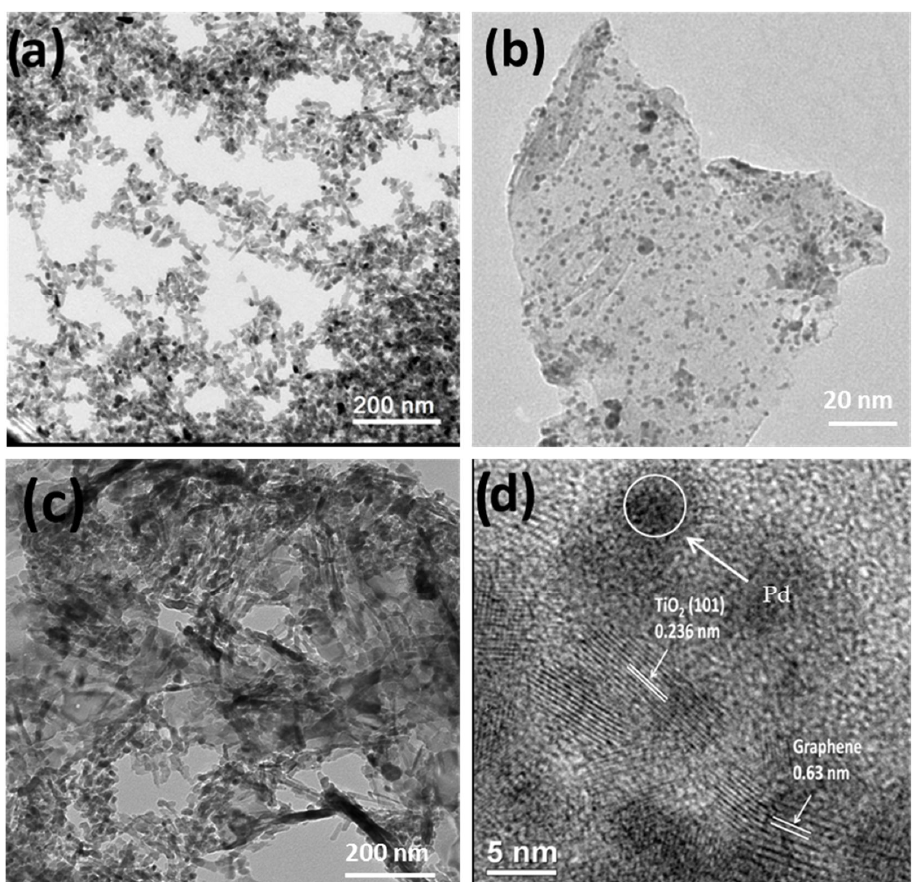
Figure 4. Transmission electron microscopy (TEM) images of pristine TNRs ( a ), Pd 1 -rGO ( b ) and Pd 1 /rGO 4 −TNR ( c , d ). Pd 1 /rGO 4 − TNR ( c , d